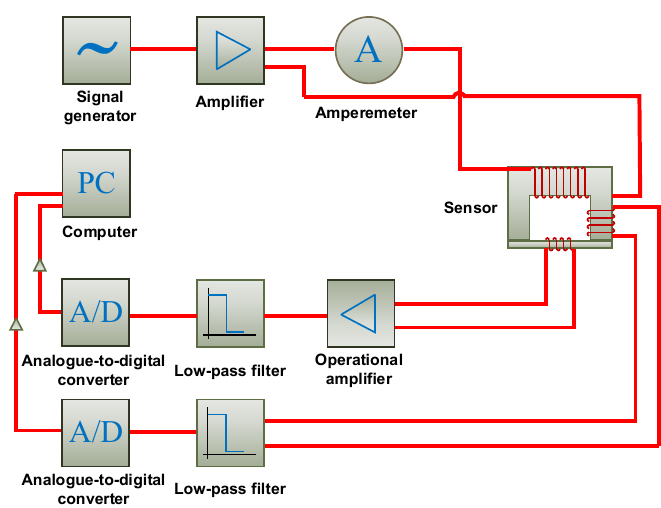
Figure 5. A block scheme of the measuring system.